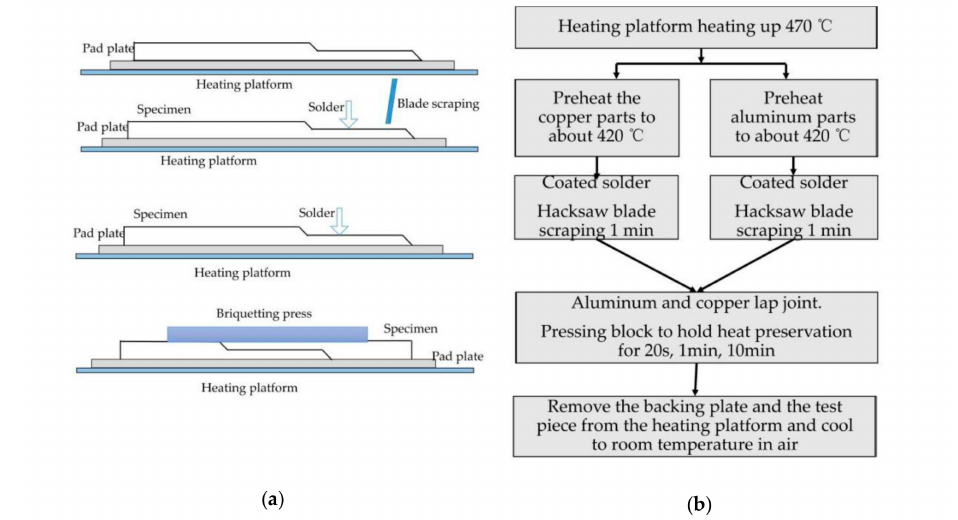
Figure 4. Brazing process parameters. ( a ) Schematic diagram of brazing process. ( b ) Brazing